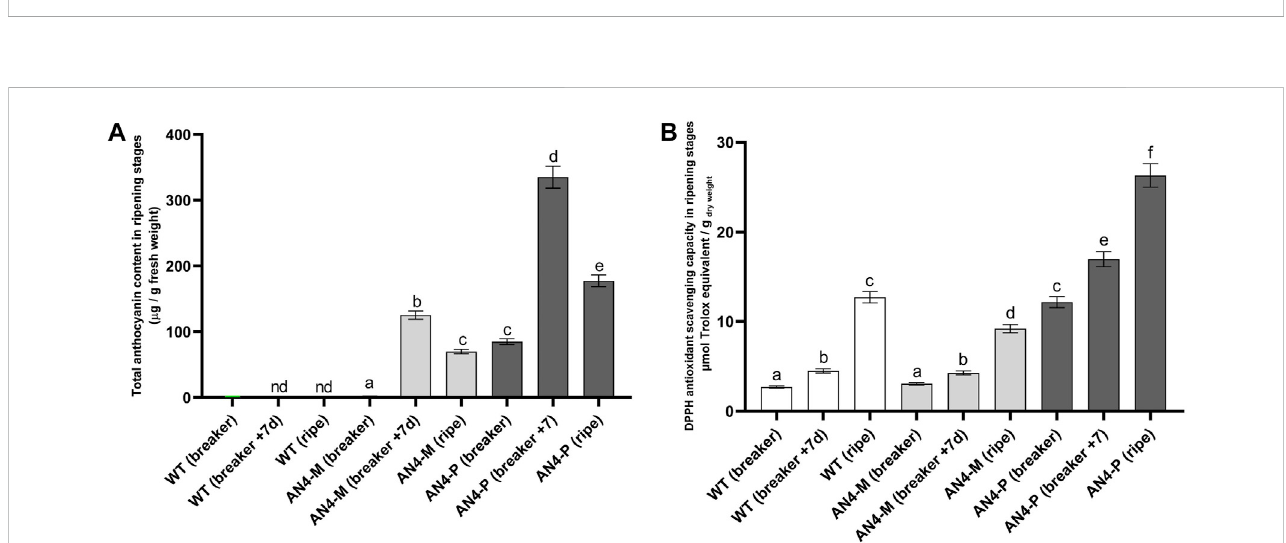
FIGURE 5 Total anthocyanin content in wild type and engineered tomato fruits (A) . The amount of anthocyanins is expressed in µg/g of fresh weight. Each analysis consisted of triplicate measurements of each sample and data were averaged over the three measurements. Analysis of antioxidant activity (DPPH) in tomato fruits from wild type and AN4 plants (B) . Results are expressed as µg Trolox equivalents/g dry weight (DW). A univariate statistical analysis based on Student ’ s test and one way-ANOVA ( p ≤ .05) was carried